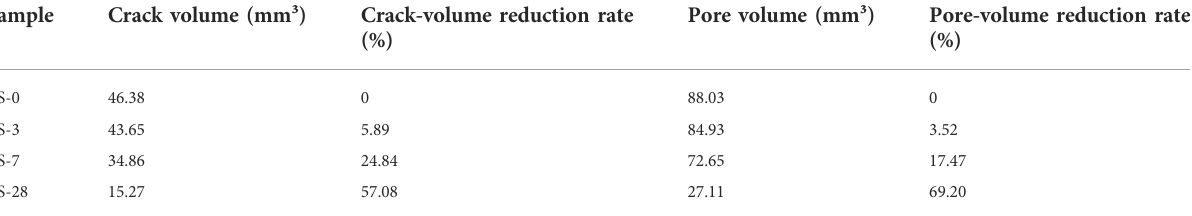
TABLE 4 Changes in the crack volume and pore volume of the CS